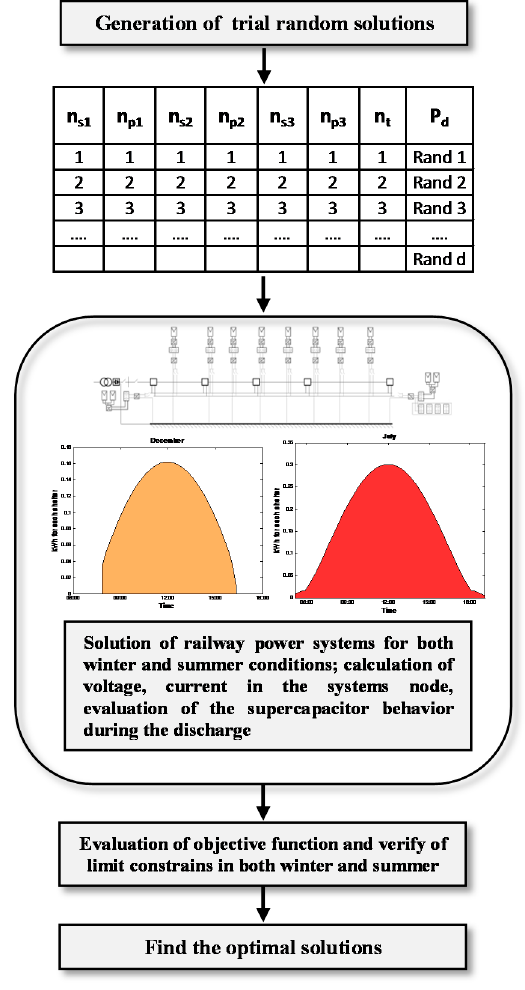
Figure 5. Flow chart of the optimization procedure.